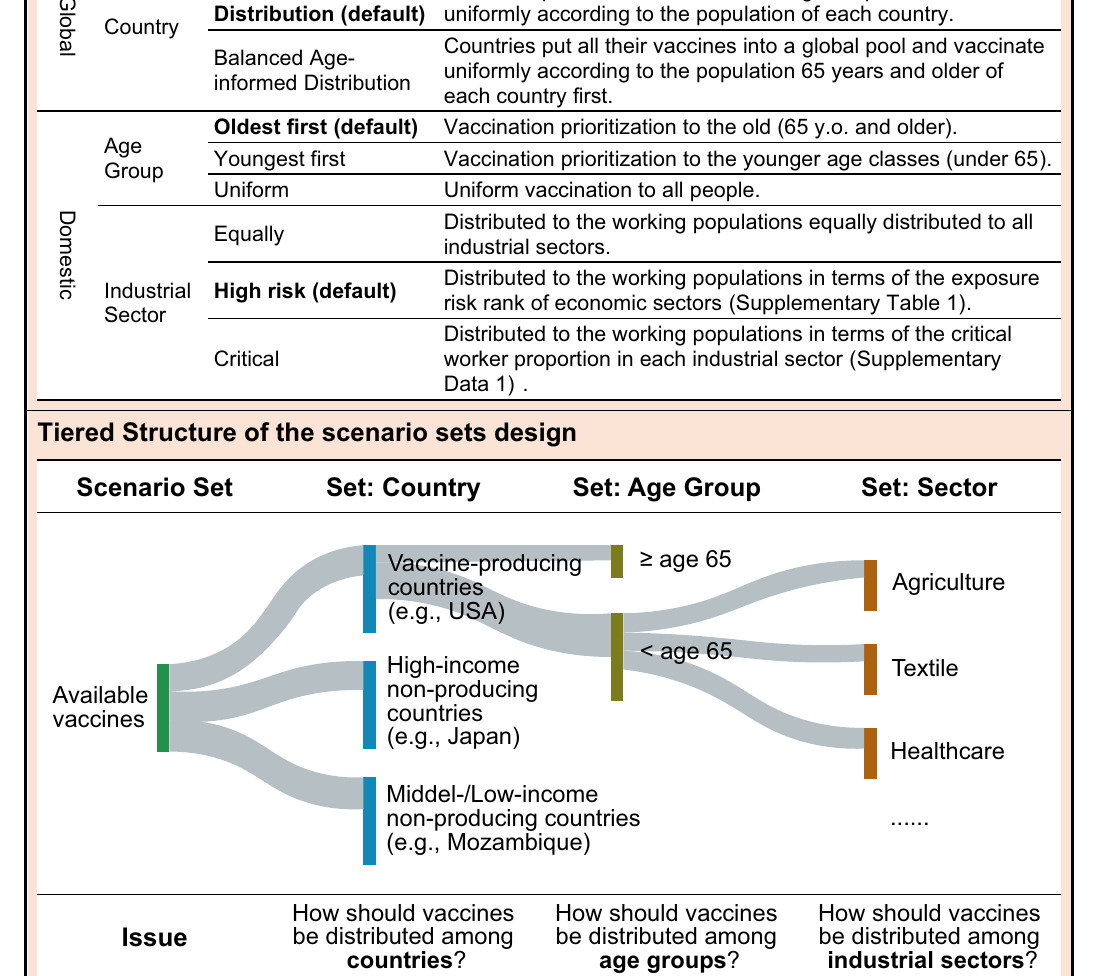
Fig.1|Scenariosetting,explanation,andjusti fi cation. Wedesignedthreesetsof scenarios integrated into a tiered structure. Basically, Tier Global set of scenarios addressestheissueofthecooperativeattitudeofvaccine-producingcountriesand vaccine-importing countries, while Tier Domestic set of scenarios addresses the issueofhowreceivedvaccines(vaccinessentbyproducingcountries)areallocated